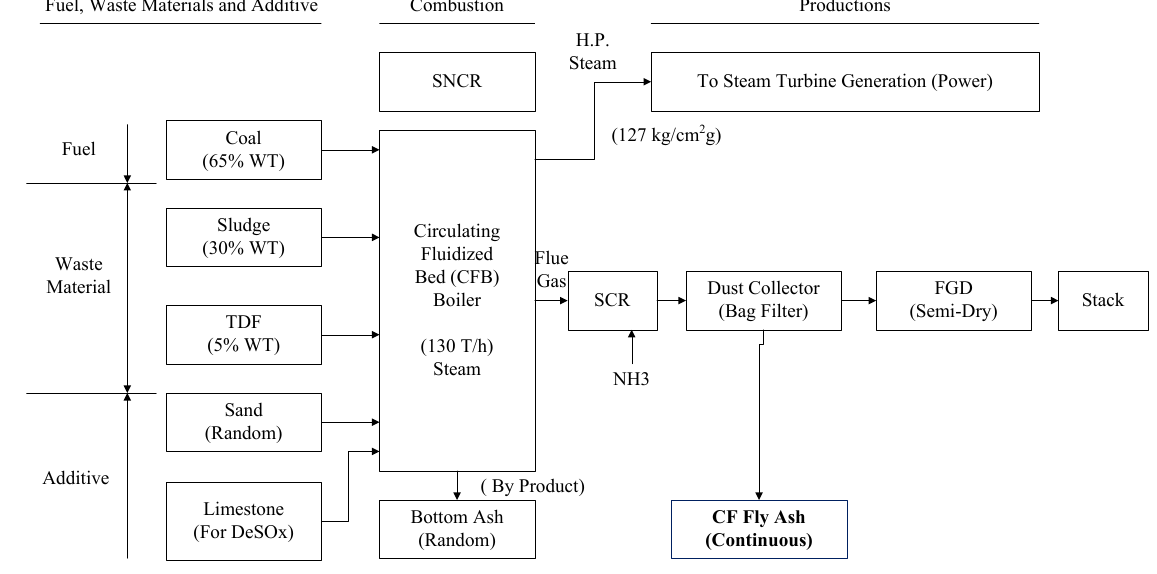
Figure 1. Circulating fluidized beds (CFB) combustion